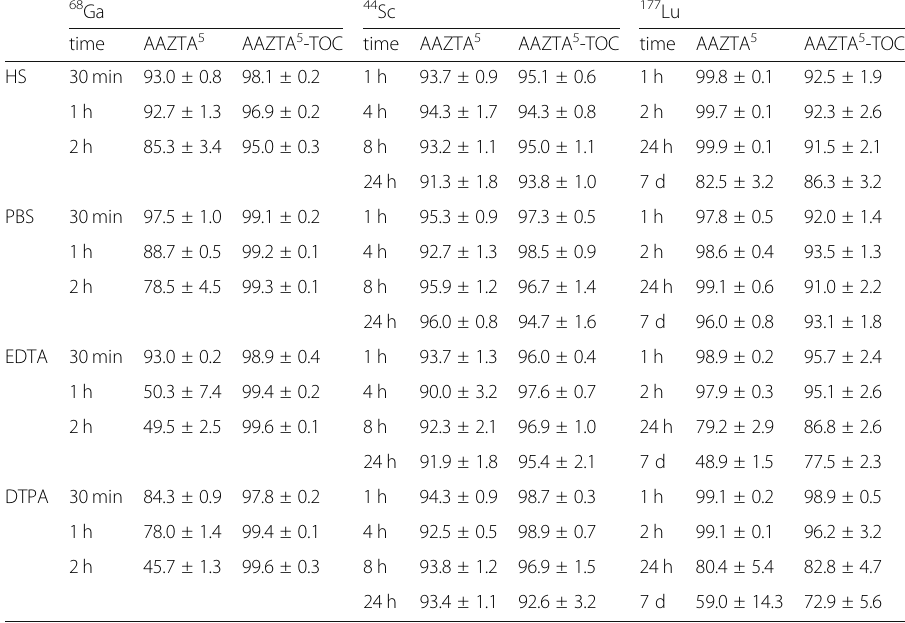
Table 2 Stability data for 68 Ga, 44 Sc and 177 Lu complexes of AAZTA 5 and AAZTA 5 -TOC against human serum, PBS buffer and EDTA and DTPA in PBS buffer in percent of stable complex at specific time points (% labelled compound compared to free activity found at given time point) 68 Ga 44 Sc